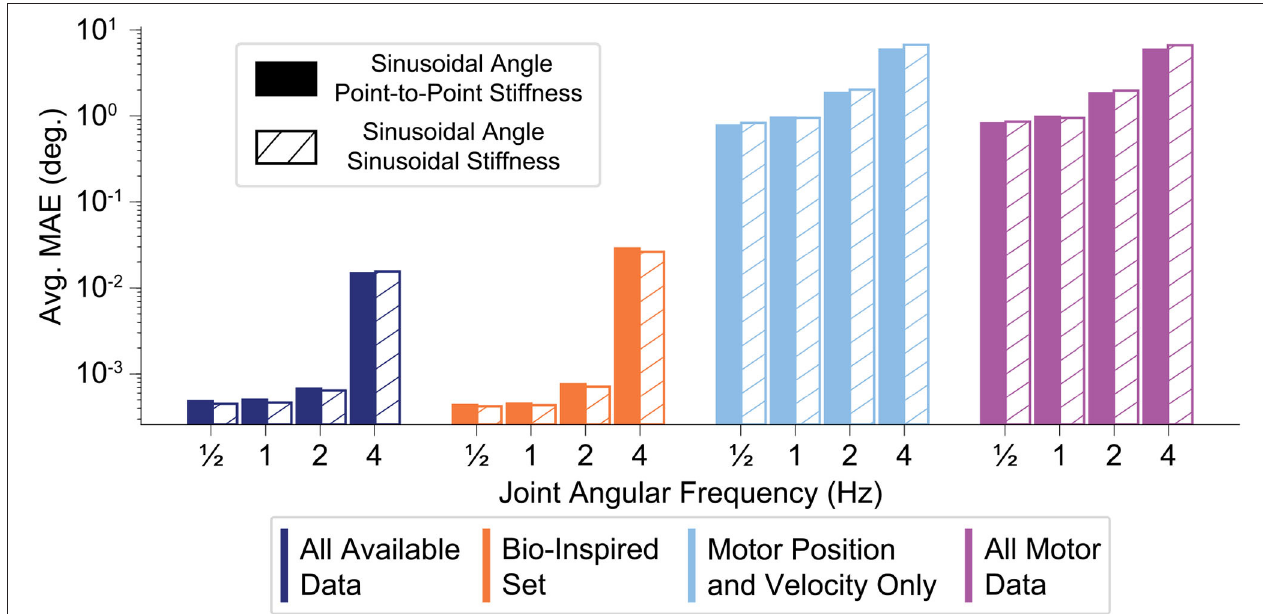
FIGURE 11 | Bar plot of the average performance (MAE) of each sensory set (N=50 ANNs) as function of the frequency of the sinusoidal joint angle trajectory. The joint stiffness was either varied sinusoidally or by a point-to-point task (18)–(19). The ANNs trained with tendon tension ( left two sets ) appear to generalize better to higher frequency movements, only worsening slightly when the movements becomes fastest. The ANNs trained only with motor information may decrease their performance by a similar order of magnitude, but there is quite a difference between producing average errors of 10 − 2 and 10 1